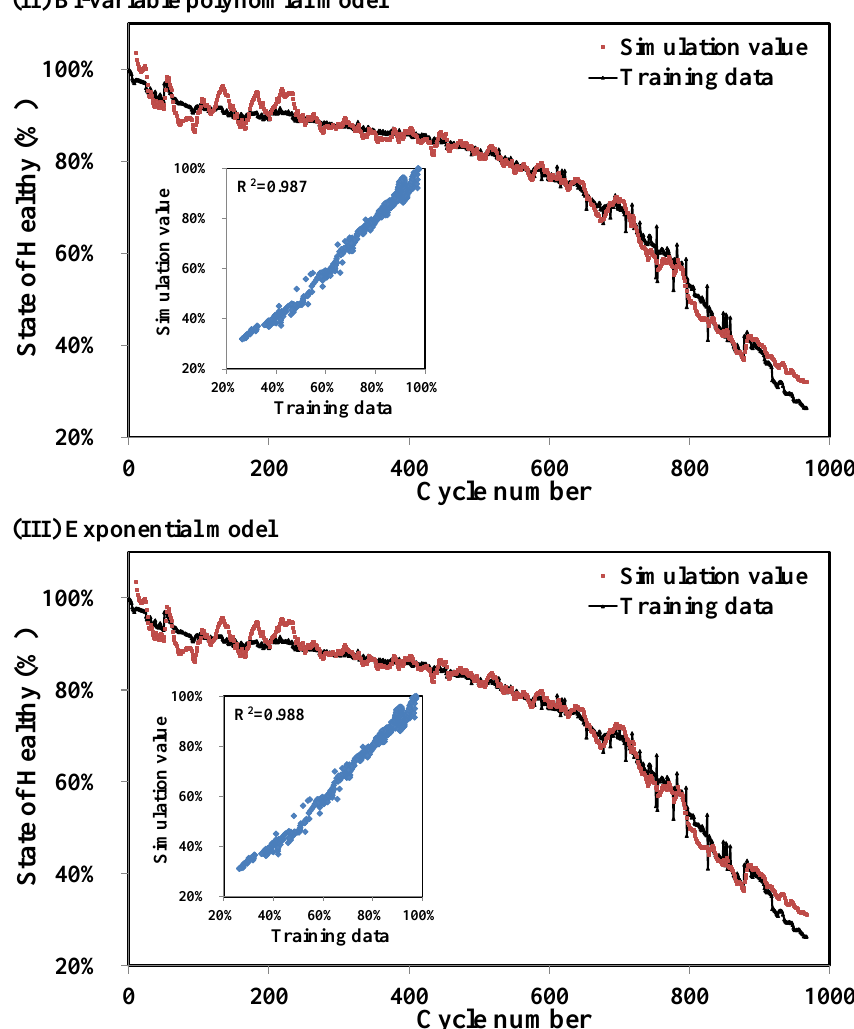
Figure 7. SOH degradation curves of three different